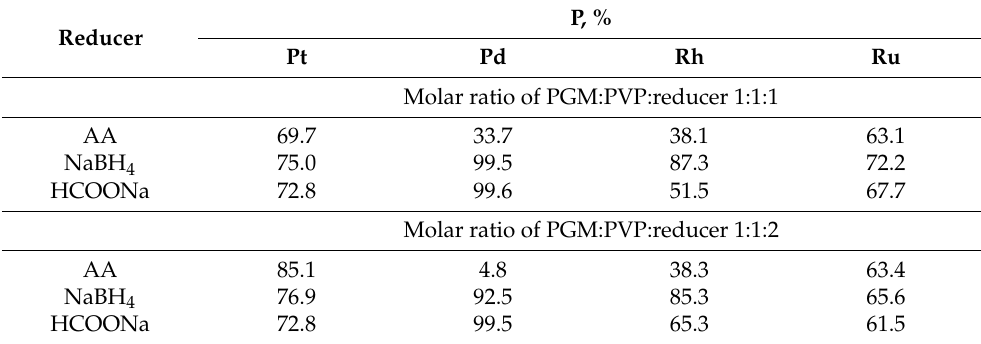
Table 1. Precipitation yield (P) of Pt, Pd, Rh, and Ru using one of three reducers: AA, NaBH 4 and HCOONa.